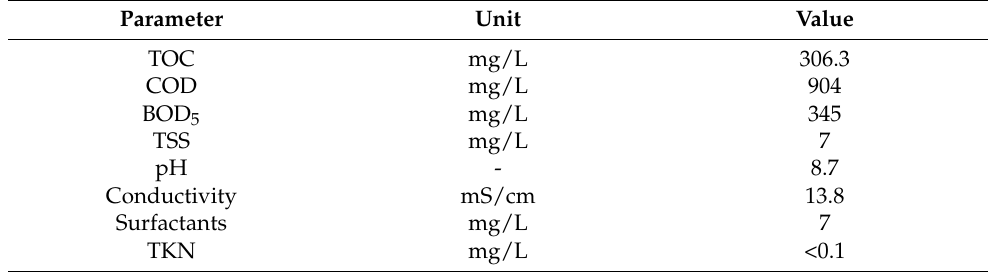
Table 1. Cosmetic wastewater